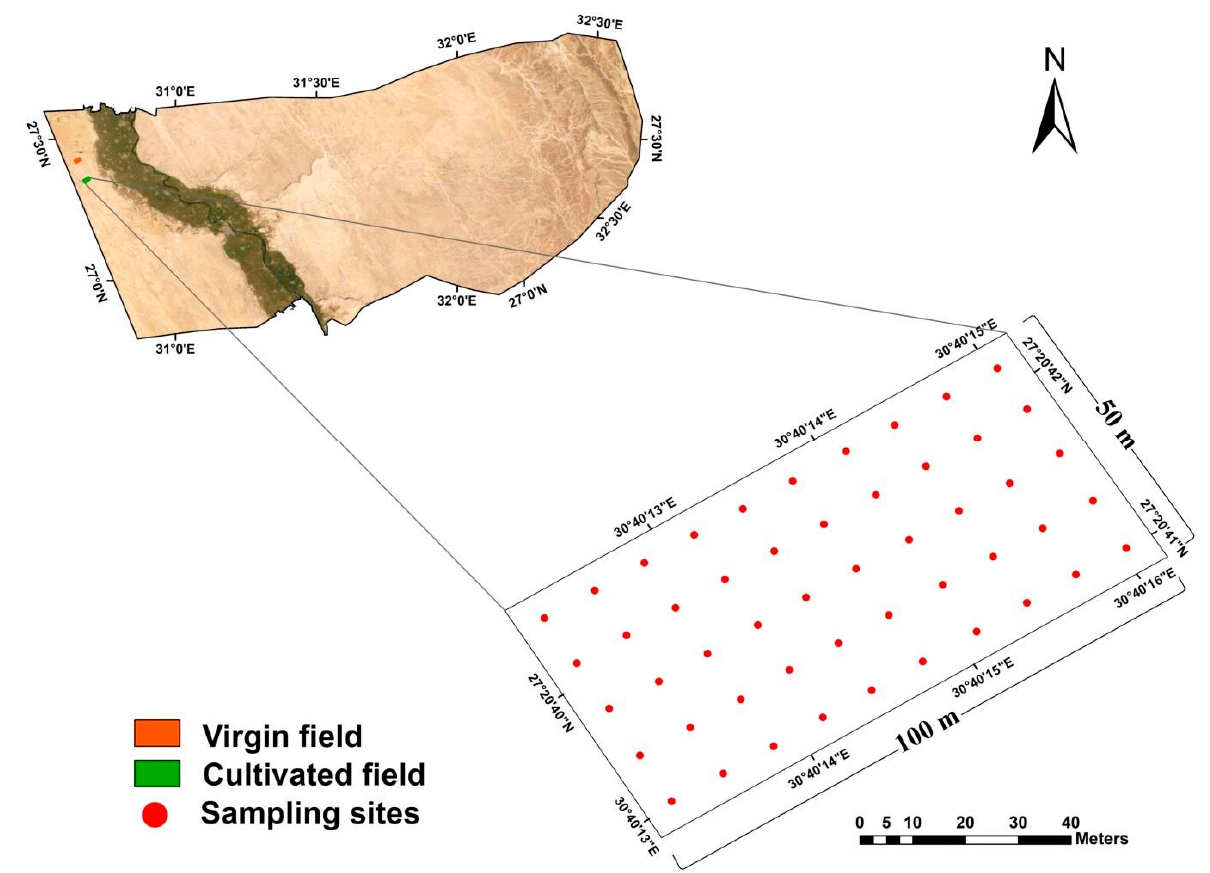
Figure 3. The study sites and soil sampling design.